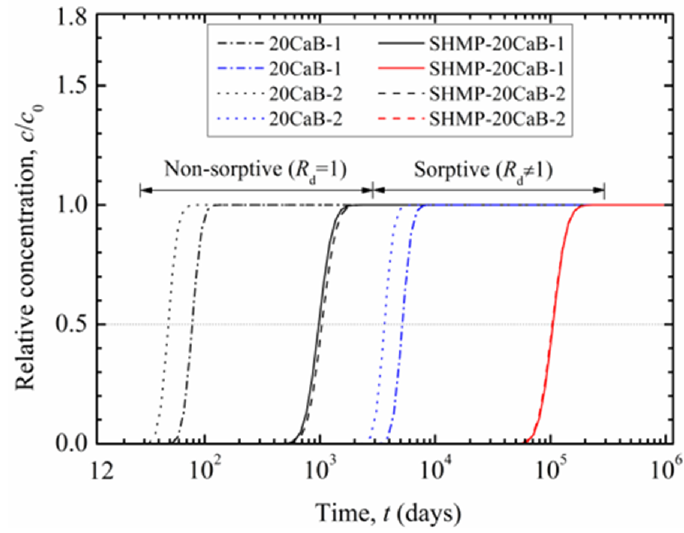
Figure 5. Predicted breakthrough curves for unamended and amended backfills with source Pb concentration = 1000 mg / L and wall thickness = 1 m. Table 4. Summary of predicted breakthrough times for 1000 mg / L Pb transport through a 1-m-thick SB slurry wall.